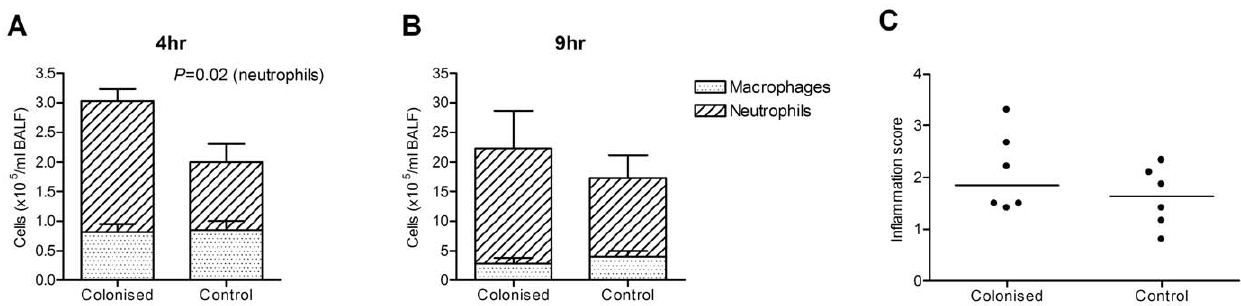
Figure 4. Effect of prior colonisation on inflammation during subsequent pneumonia. (A–B) Numbers of neutrophils (hatched region) and macrophages (dotted region) present in BALF of previously colonised or control CBA/Ca mice at (A) 4 h and (B) 9 h following pneumonia challenge. Bars represent mean + SEM (n=6 mice per group). (C) Lung inflammation scores assessed by blinded histological examination of lung sections collected 18 h following challenge of colonised or control mice. Dots represent individual mice, bars represent medians. doi:10.1371/journal.pone.0025558.g004 labelled D39 there were no differences in the association of mice (Fig. 8B), confirming that serum antibody from colonised fluorescent S. pneumoniae with alveolar macrophages recovered CBA/Ca mice bound to the S. pneumoniae surface was responsible from BALF 4 h post-inoculation (Fig. 8C). Hence colonisation for the enhanced phagocytosis in this serum. In contrast, when resulted in improved antibody dependent phagocytosis in serum colonised and control mice were challenged with FAM-SE-